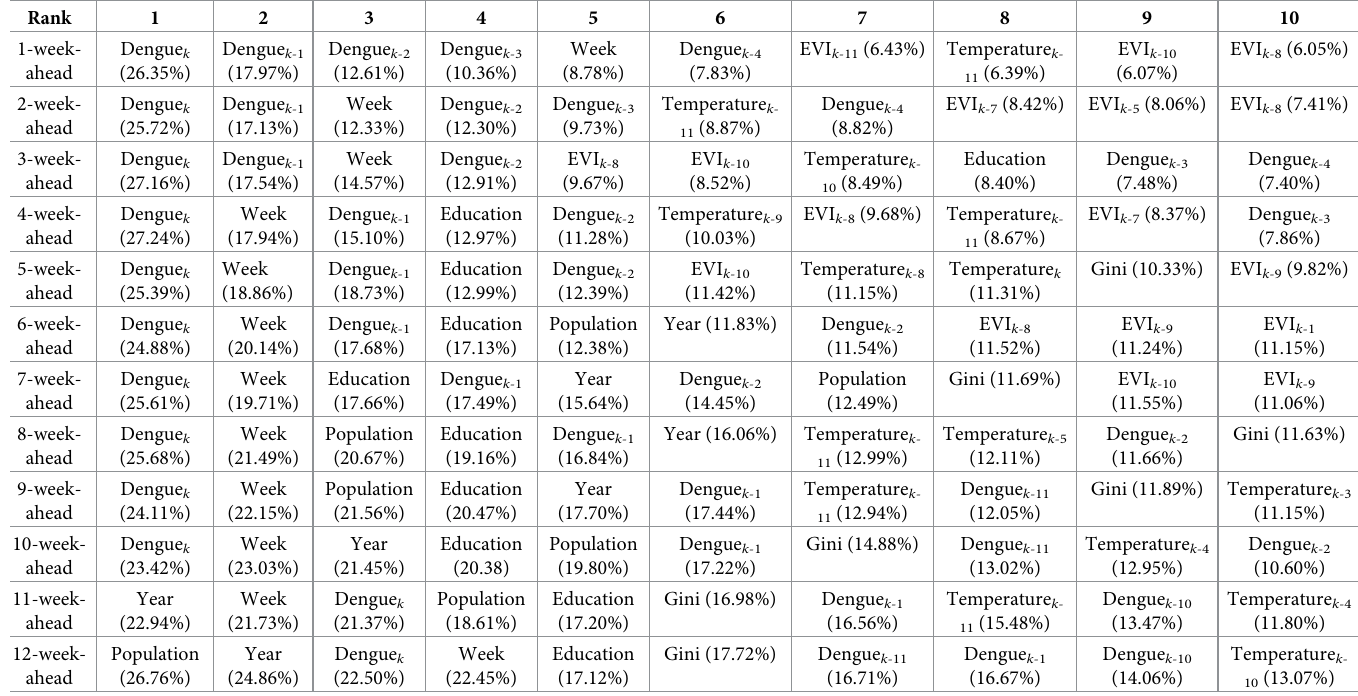
Table 5. The top ten most important predictor variables for predicting dengue cases in the national models, ordered from the largest to the smallest